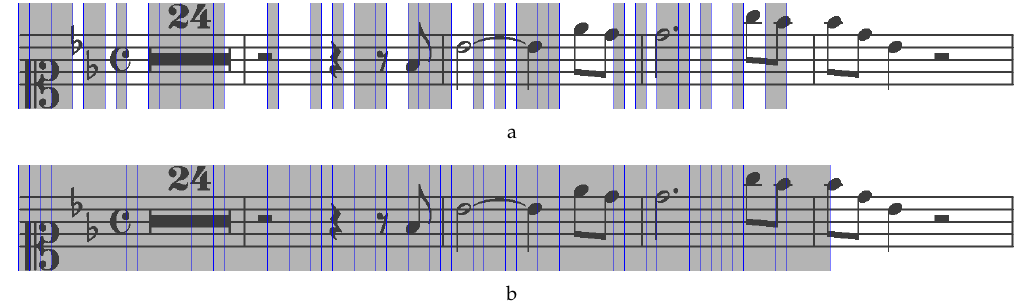
Figure 7. Example of symbol localization with respect to the different output representations. Gray areas correspond to detected symbols, while the blue lines indicates boundaries. Columns with no highlight are those in which the model predicts blank . ( a ) Agnostic representation; ( b ) Semantic